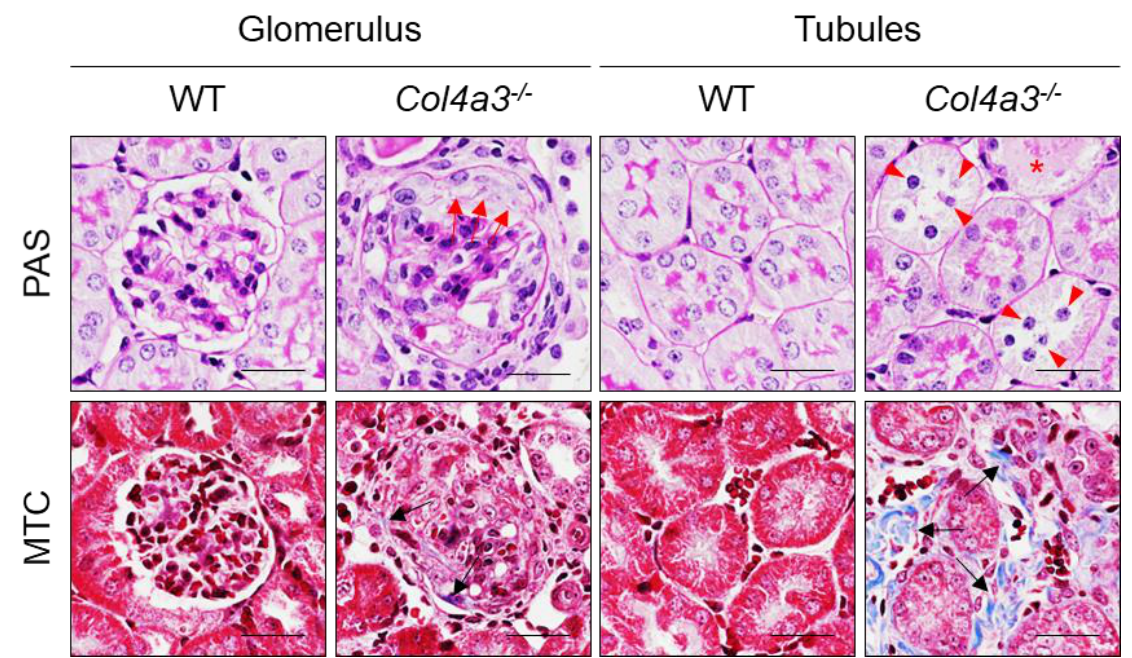
Figure 2. Comparisons of the Kidney Tissue Morphology of Kidney of WT and Col4a3 -/- mice. Images from glomerulus (left) and tubulointerstitium (right) are presented. Periodic Acid Schiff staining (PAS); Masson’s trichrome staining (MTC). In Col4a3 -/- mice, crescents are packing the Bowman’s space (red arrows). Detachment of tubular epithelial cells from basement membrane (red arrowheads), tubular cast (red asterisks), and collagen deposits (black arrows) are also indicated. Scale bars, 50 μm.